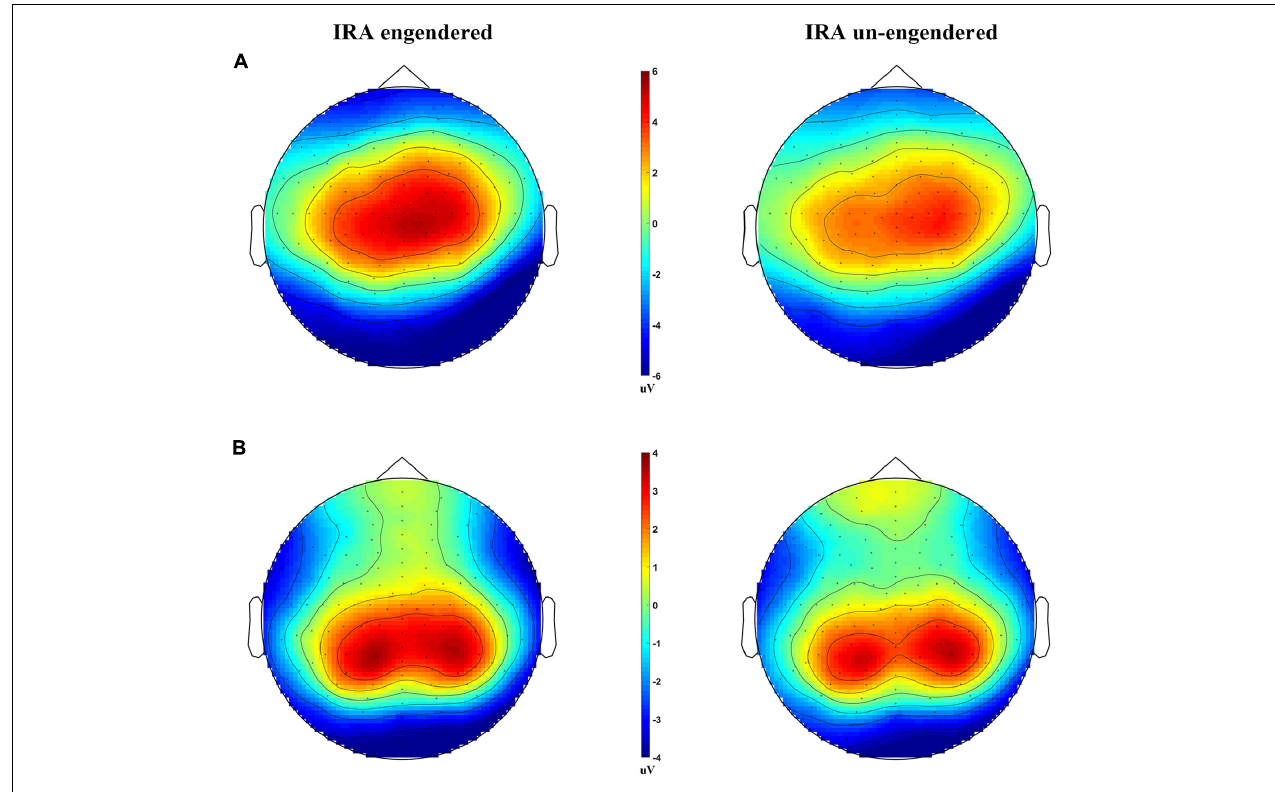
FIGURE 3 | Scalp distributions of the LPP and P300, for the IRA engendered and IRA un-engendered conditions. (A) The LPP. (B) The